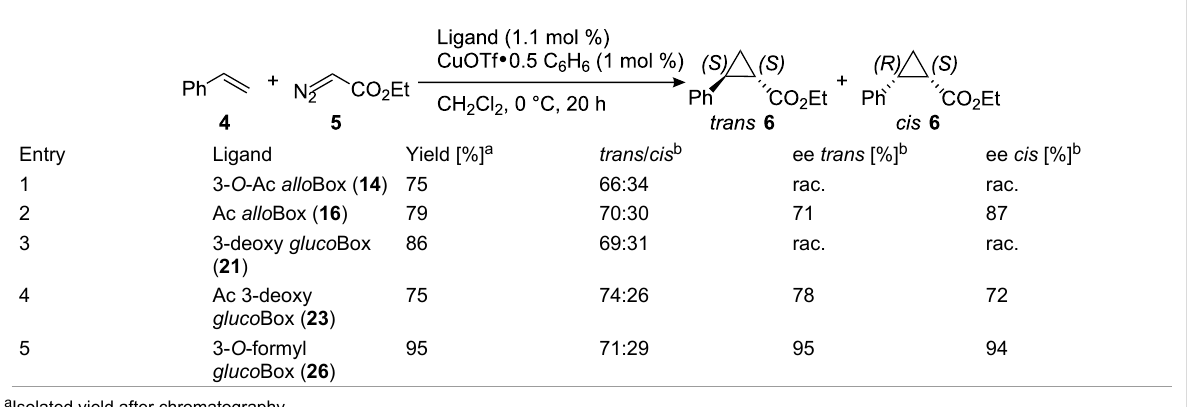
Table 1: Cyclopropanations with allo -configured ligands 14 and 16 , 3-deoxygenated ligands 21 and 23 and 3- O -formylated, gluco -configured ligand 26 .